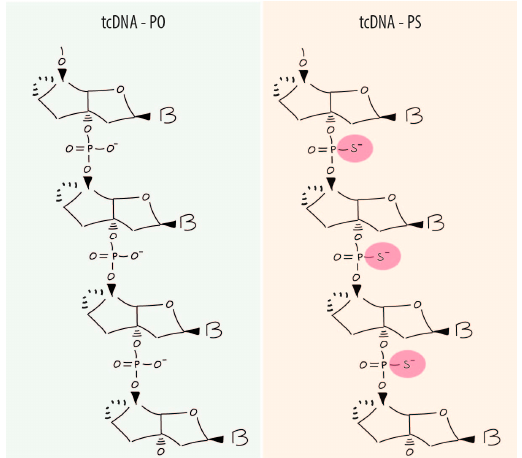
Figure 1. Antisense tcDNA molecule with natural phospodiester (PO) (left panel) or modified phosphorothioate (PS) (right panel) backbones (B = base adenine, guanine, cytosine or thymidine).